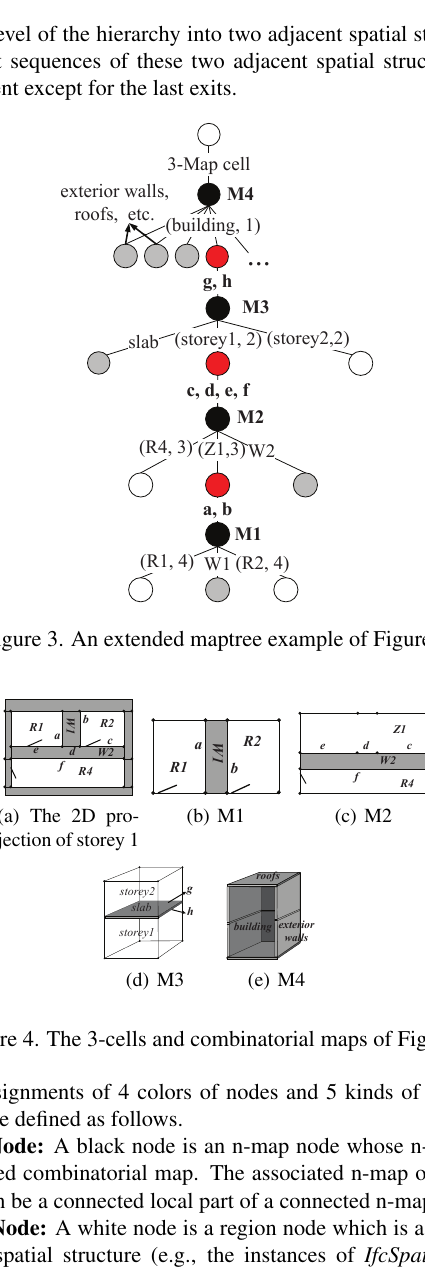
Figure 1. The UML diagram of the related IFC classes in this paper